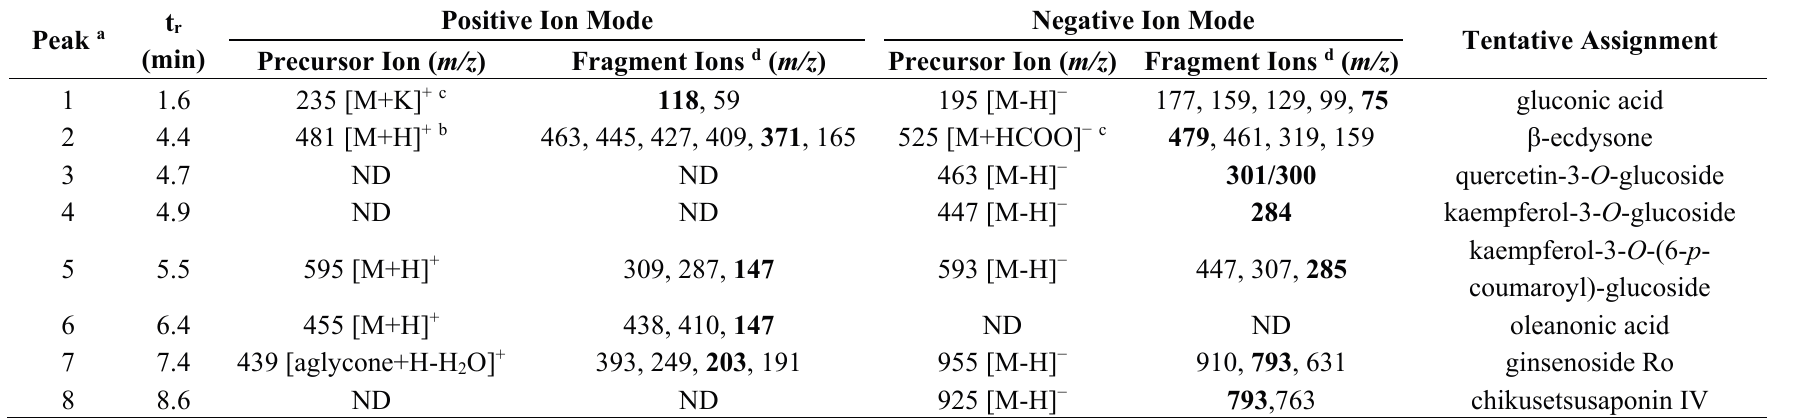
Negative Ion Mode Tentative Assignment